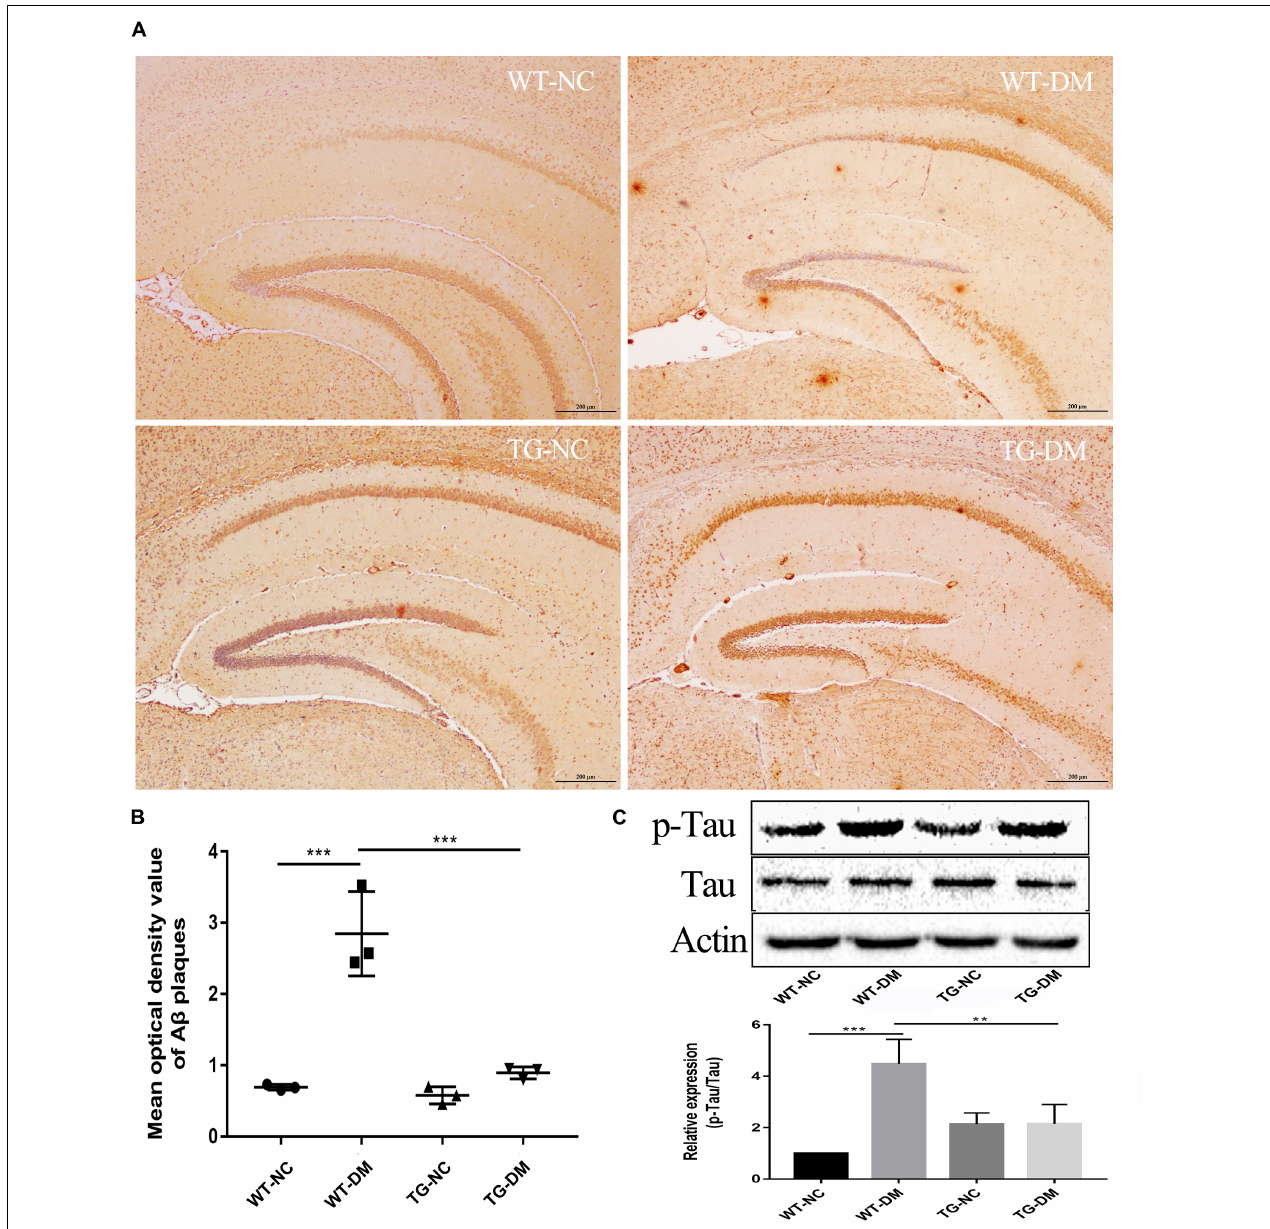
FIGURE 3 | Trx-1 reduced A β burden and Tau phosphorylation in DM mice. (A) Representative images of A β deposits in the hippocampus. (B) Quantitative statistical analysis of A β density value in the hippocampus. (C) Representative Western blot images and analysis of Tau and p-Tau. Tukey’s post hoc test for one-way ANOVA used for A β density value and Western blot immunocontent. For each group, n = 6. The vertical lines represent the standard error of the mean. ** p < 0.01, *** p <